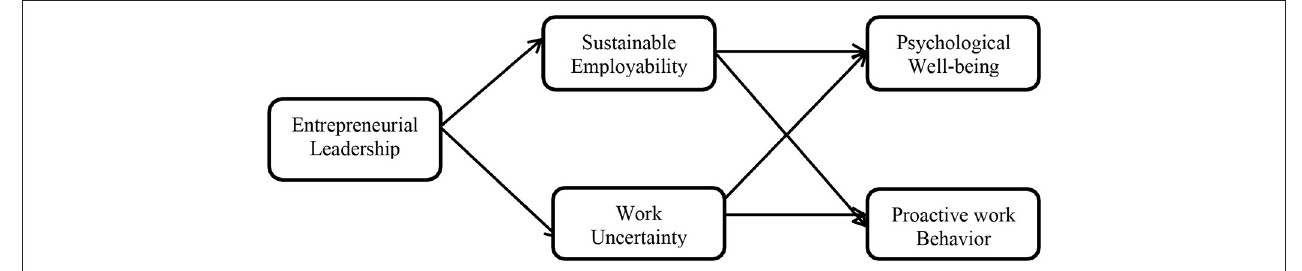
FIGURE 1 | Conceptual